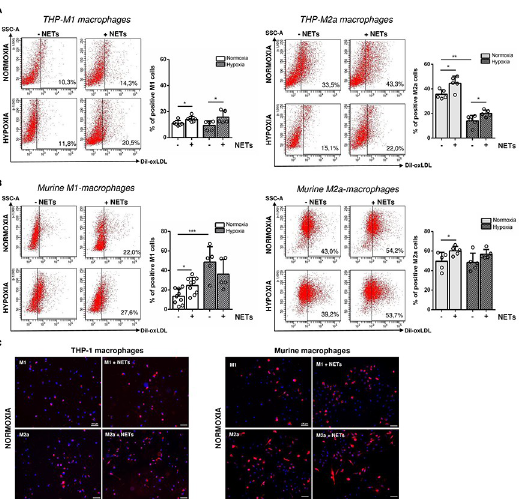
Fig 3. Effect of NETs on oxLDL uptake by polarized human and murine macrophages. The uptake of Dil-labeled oxidized LDL (oxLDL) by human (A) and murine (B), polarized macrophages (M1 and M2a) treated with NETs and cultured under normoxic or hypoxic culture conditions was quantified by flow cytometry. n = 5–9. Representative dot plots are depicted. (C) Dil-oxLDL uptake under normoxia was visualized and confirmed by immunofluorescence. Representative images of three independent experiments are depicted. � P < 0.05, �� P < 0.01, ��� P < 0.001 (Unpaired t test, Mann-Whitney test).